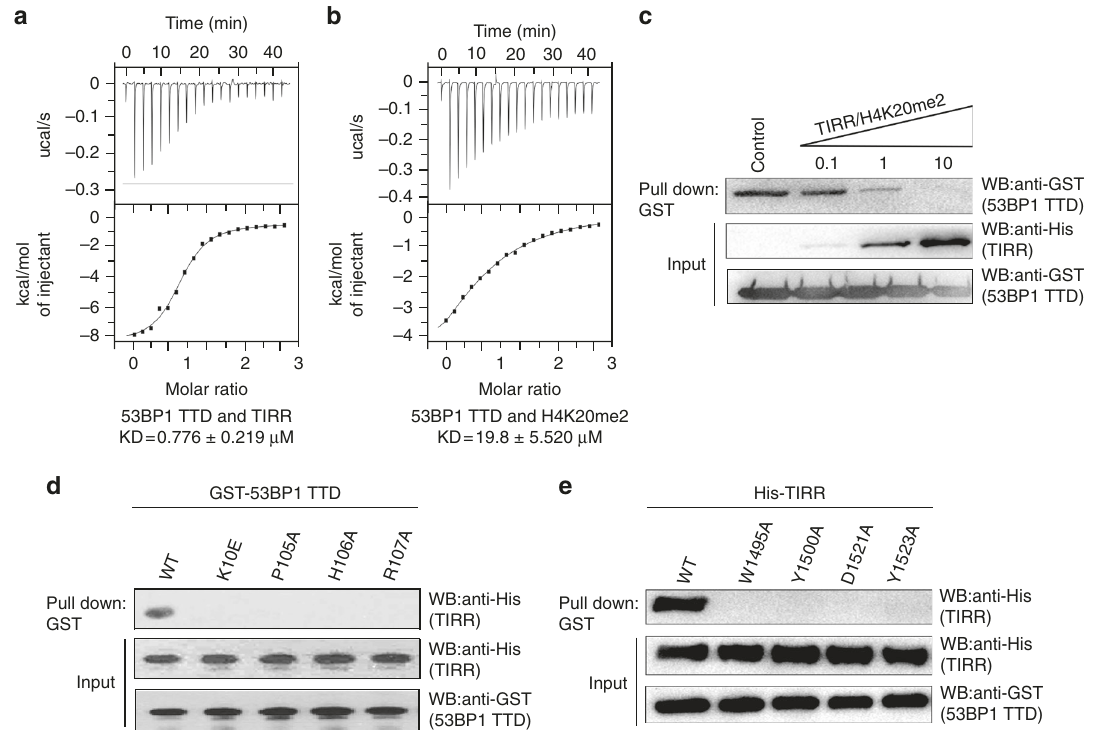
Fig. 3 The in-vitro binding analysis of the TIRR – 53BP1 TTD complex. a The ITC titration of wild-type TIRR with 53BP1 TTD. b The ITC titration of 53BP1 TTD with H4K20me2 peptide (residues 12 – 25). c TIRR competes out H4K20me2 peptide (residues 12 – 25) for the interaction with 53BP1 TTD. 0.1, 1, and 10 represent the molar ratio between TIRR and H4K20me2 in each sample. d The mutations of TIRR abolish the interaction with 53BP1 TTD. The in-vitro interaction between TIRR and 53BP1 TTD was examined by the GST pull-down assay and western blot with indicated antibodies. e The mutations of 53BP1 TTD abolish the interaction with TIRR. Uncropped blots are shown in Supplementary Fig. molecules (Supplementary Fig. 5a). PISA analysis reveals that the